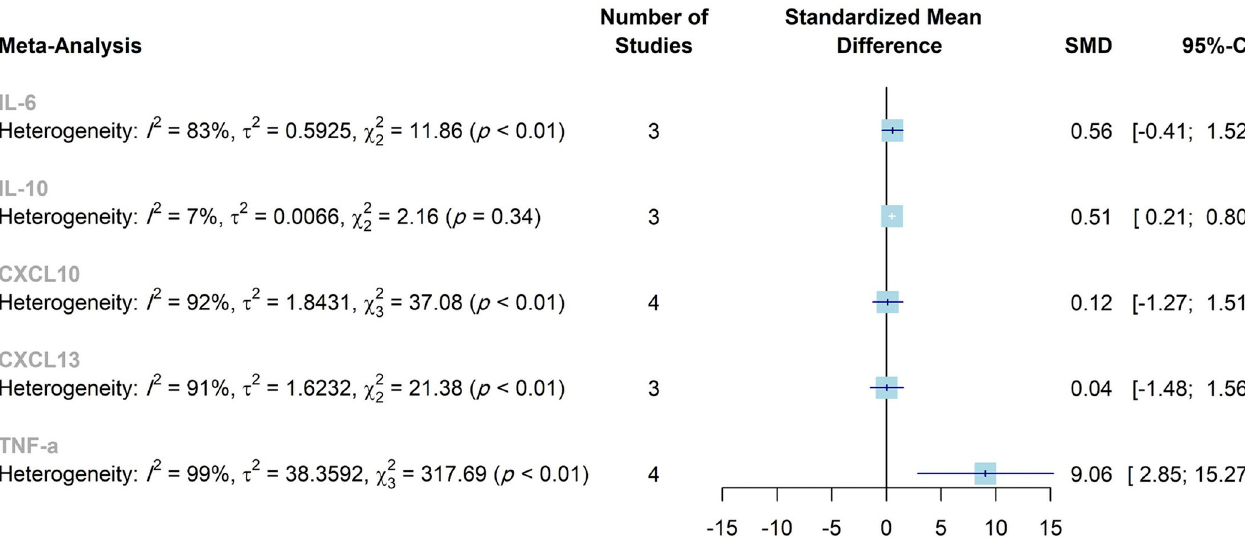
Fig 8. Summary of the overall effects and heterogeneity of the concentrations of the cytokines in the serum/plasma. SMD, standardized mean difference; CI, confidence interval.